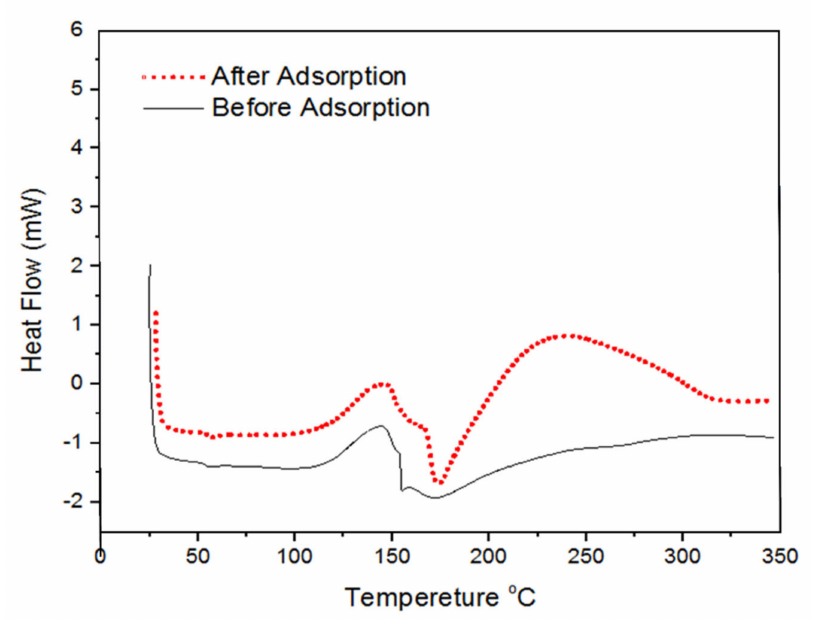
Figure 7. DSC curve of